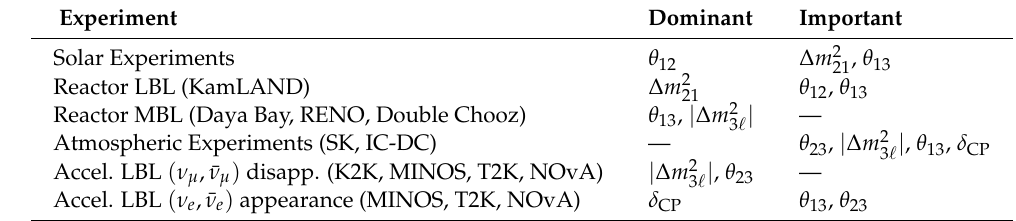
, θ 13 21 θ 12 , θ 13 21 | — 3 (cid:96) | , θ 13 , δ CP 3 (cid:96) | , θ 23 — 3 (cid:96) δ CP θ 13 , θ